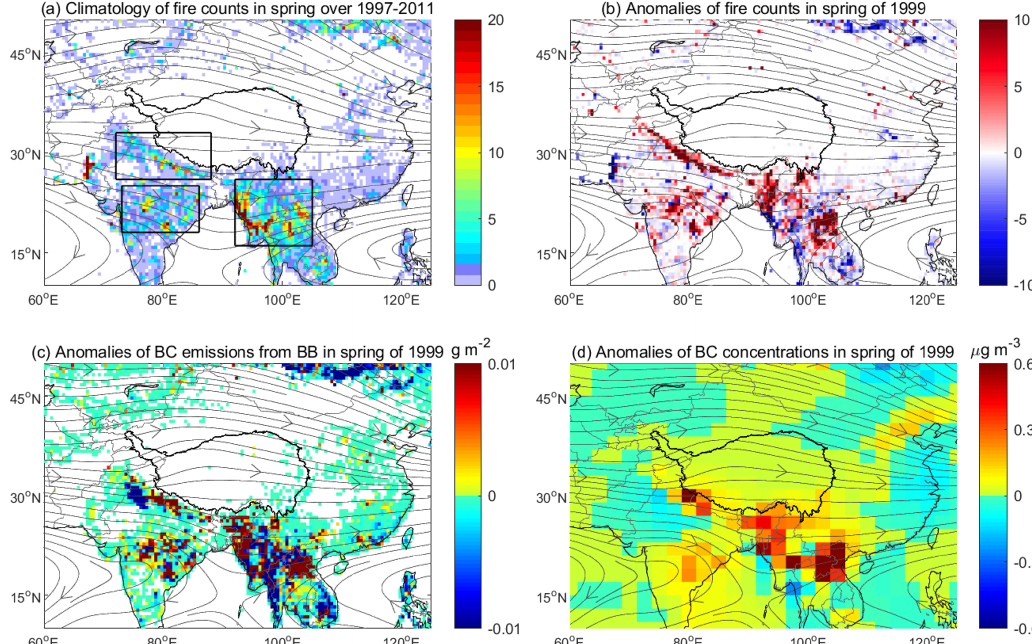
Figure 8. Extremely strong biomass burning in spring of 1999 and the corresponding surface BC anomalies and wind field over the TP and surrounding regions. (a) Climatology of fire counts from ATSR in spring overlaid with streamlines at 500hPa over 1997–2011. (b) Anomalies of fire counts from ATSR overlaid with anomalous streamlines at 500hPa in spring of 1999. (c) The same as (b) but for the anomalies of BC emissions from biomass burning (BB) from GFED3. (d) The same as (b) but for the anomalies of BC concentrations from the CTRL simulation. The anomaly in (b) – (d) is the corresponding value in 1999 minus that over 1997–2011. The boxed areas in (a) indicate the fire regions in the Indo-Gangetic Plain, central India, and South East Asia. The dark black line encloses the domain of the